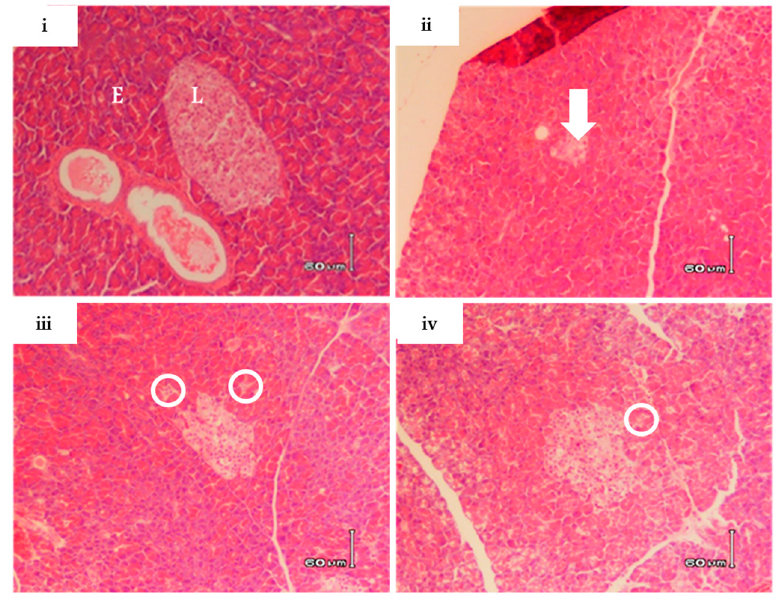
Figure 4. The effect of RA-3 on pancreatic beta cell ultrastructure in the high fat diet and streptozotocin-induced type 2 diabetic rats. ( i ) Normal structure of pancreatic islets from non-diabetic rats; ( ii ) A destructed structure as well as a reduced size of a pancreatic islets in untreated diabetic rats; ( iii ) An improved structure of pancreatic islets with some debris in diabetic rats treated with RA-3; ( iv ) A reduced size of pancreatic islets with debris of cells in diabetic rats treated with metformin. (L)-designates a normal structure of islets of Langerhans, (E) exocrine portion of pancreatic tissue, and an arrow shows destructed and condensed endocrine cells while a circle illustrates debris of destructed cells. NB: The indicator size for each image is 60 µm.